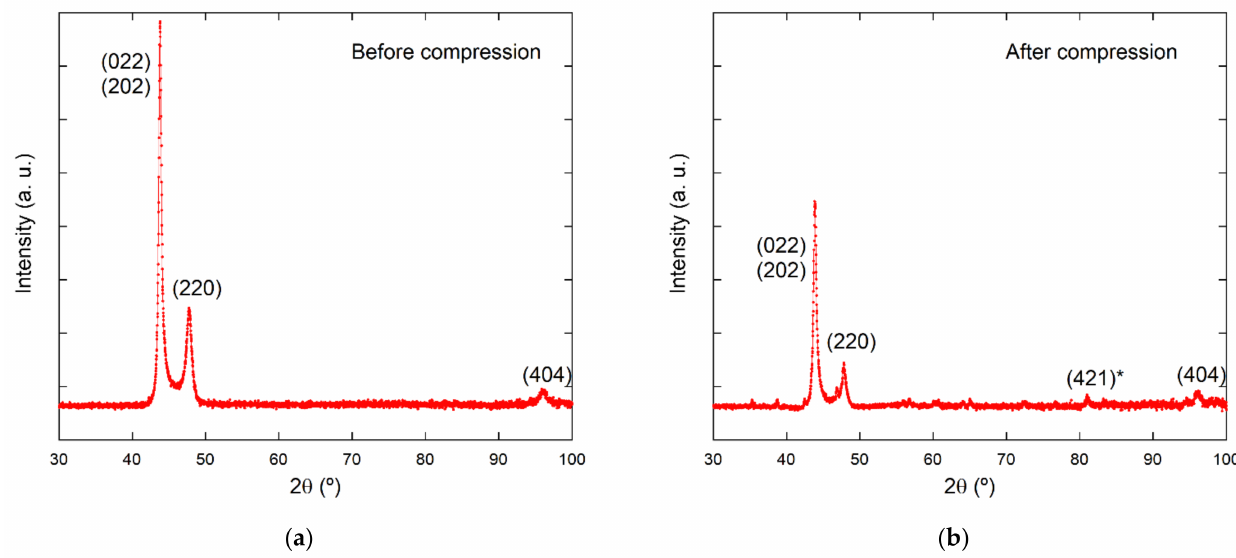
Figure 4. X-ray diffraction patterns of the basement surface of the sample in the martensitic state measured at room temperature: ( a ) before thermomechanical testing and ( b ) after the thermomechanical